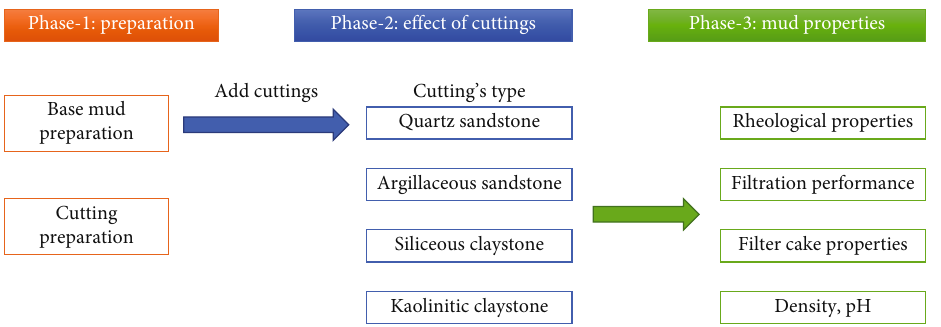
Figure 1: Mineral composition of four core samples (perspective 1).